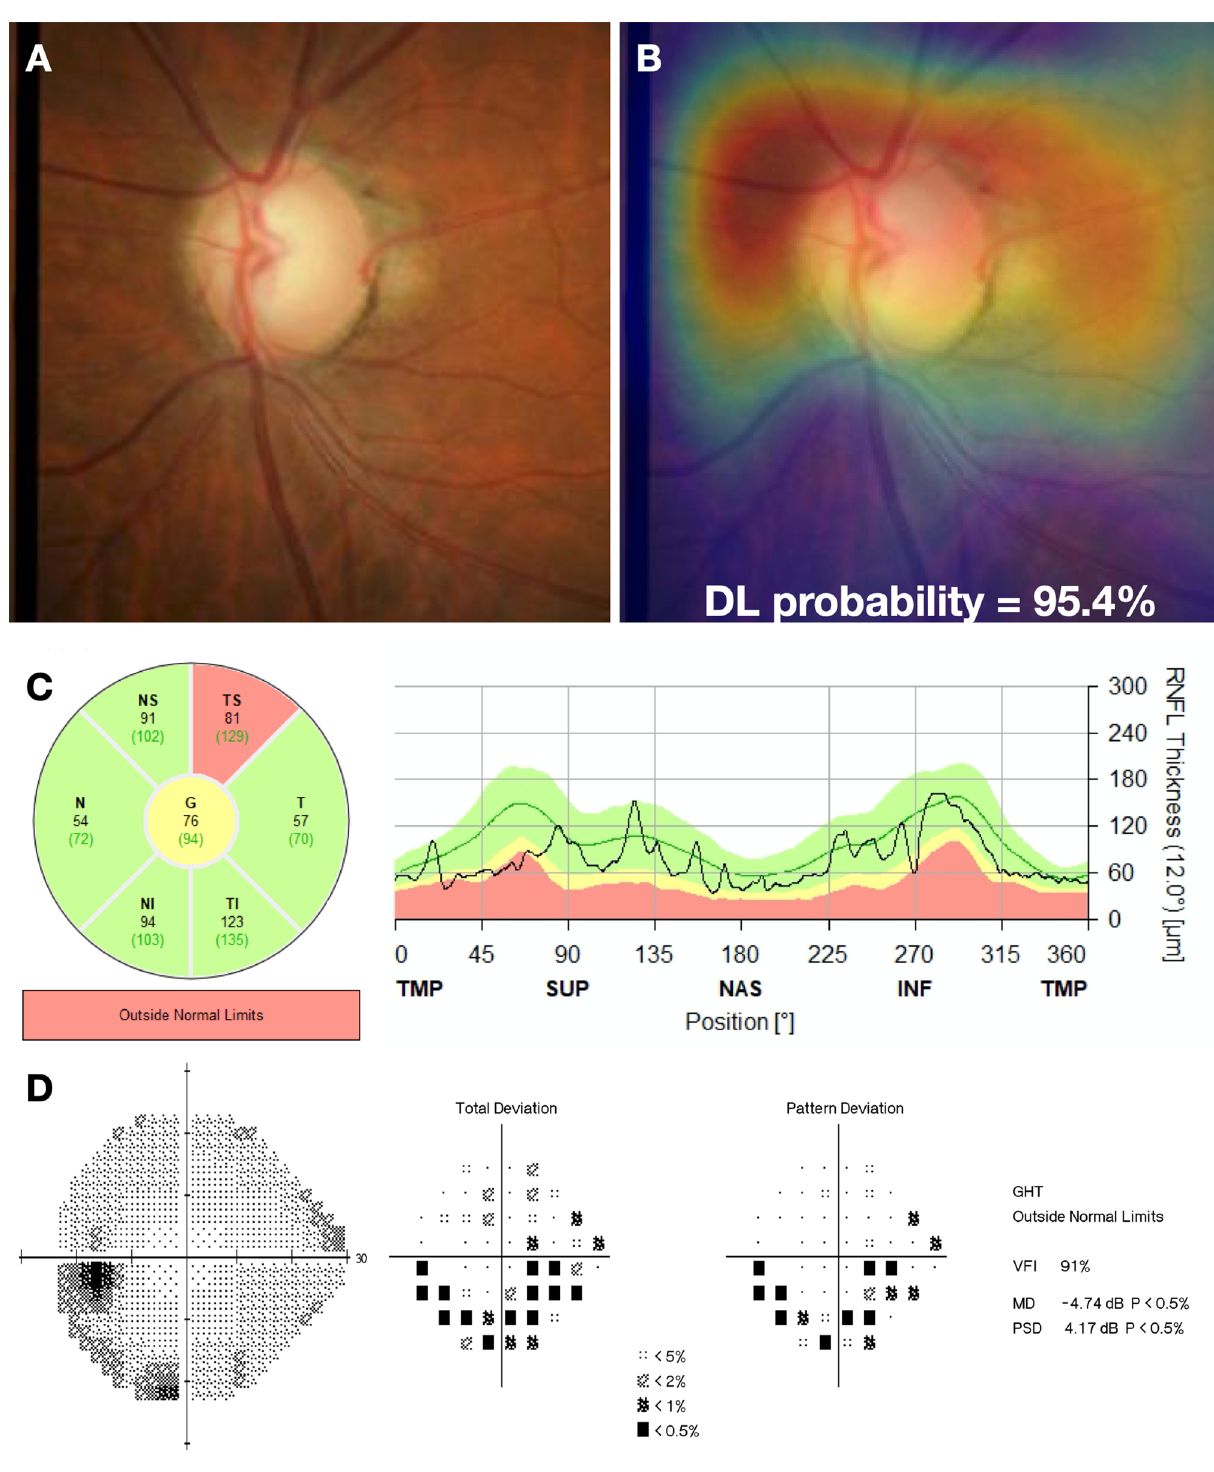
Figure 4. Example of a glaucoma case included in the study. (A) illustrates the fundus photo used as input for the deep learning (DL) algorithm, which predicted a glaucoma probability of 95.4%. (B) shows the regions that were most important for the classification, in which the heatmap highlights the superior half of the optic disc and peripapillary region. (C) illustrates the spectral domain optical coherence tomography with a temporal superior retinal nerve fibre layer defect, with a corresponding inferior arcuate defect in the standard automated perimetry (D)